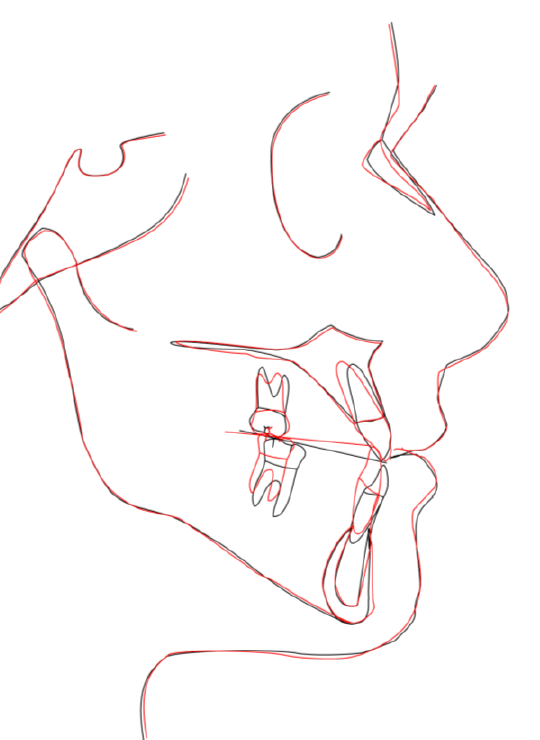
Figure 8. Cephalometric tracing superimposition: red line t1 and black line t0. Table 3. Comparison of pre- (t0) and post- (t1) cephalometric values .